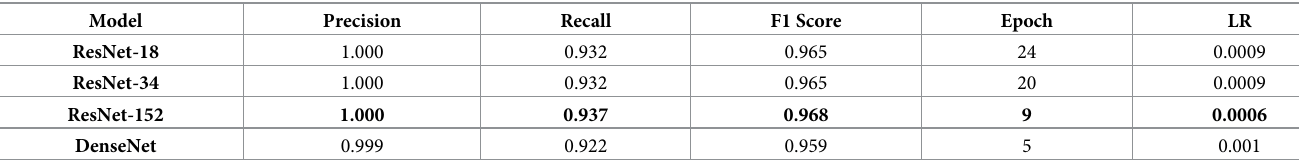
Table 3. Performance of different model types.